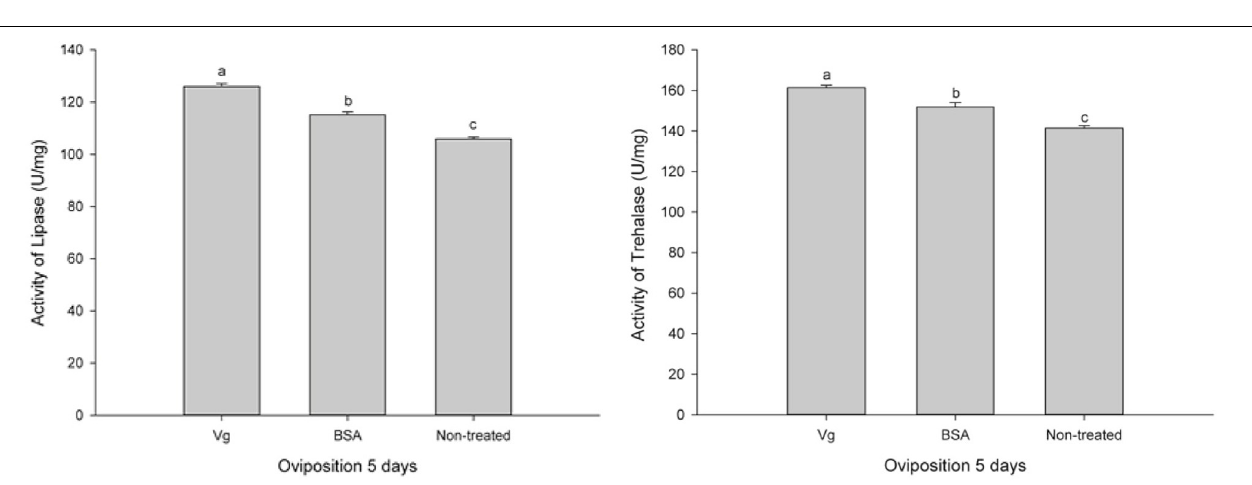
FIGURE 5 | H. axyridis lipase and trehalase activity during the female adult stage after treatment with the Vg- and BSA-supplemented artificial diets. The significance of the differences in the enzyme activities were analyzed by SPSS. The enzyme activities as shown as the means ± SEs and were found to be significantly different ( P < 0.0001).